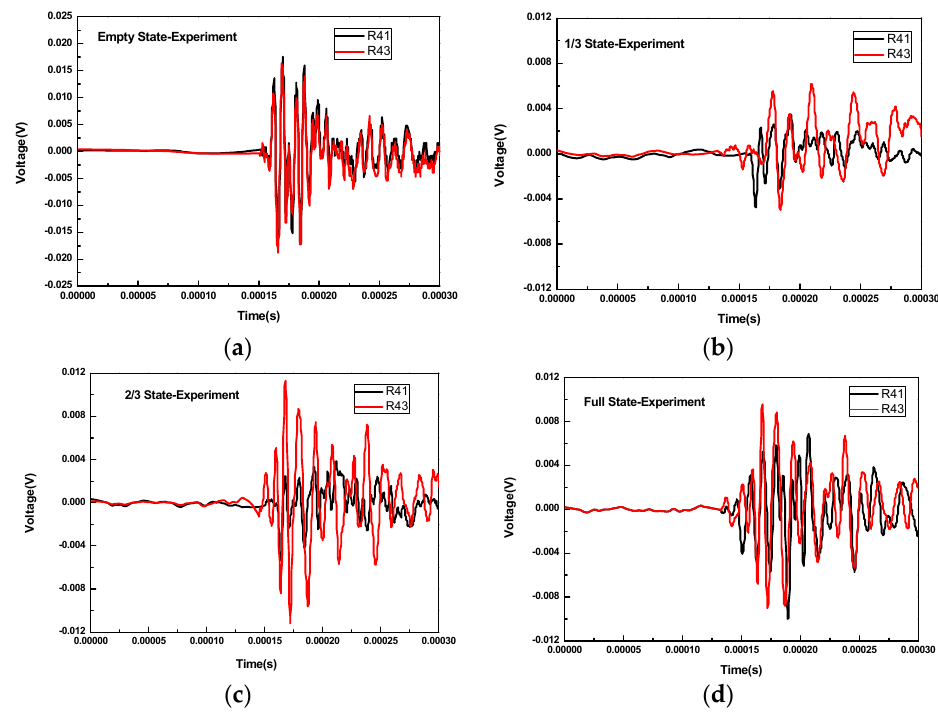
Figure 9. The waveforms received by R1 and R3 for different concrete infill conditions when R4 is used as transmitter: ( a ) the empty concrete infill; ( b ) the 1/3 concrete infill; ( c ) the 2/3 concrete infill; ( d ) the full concrete infill.